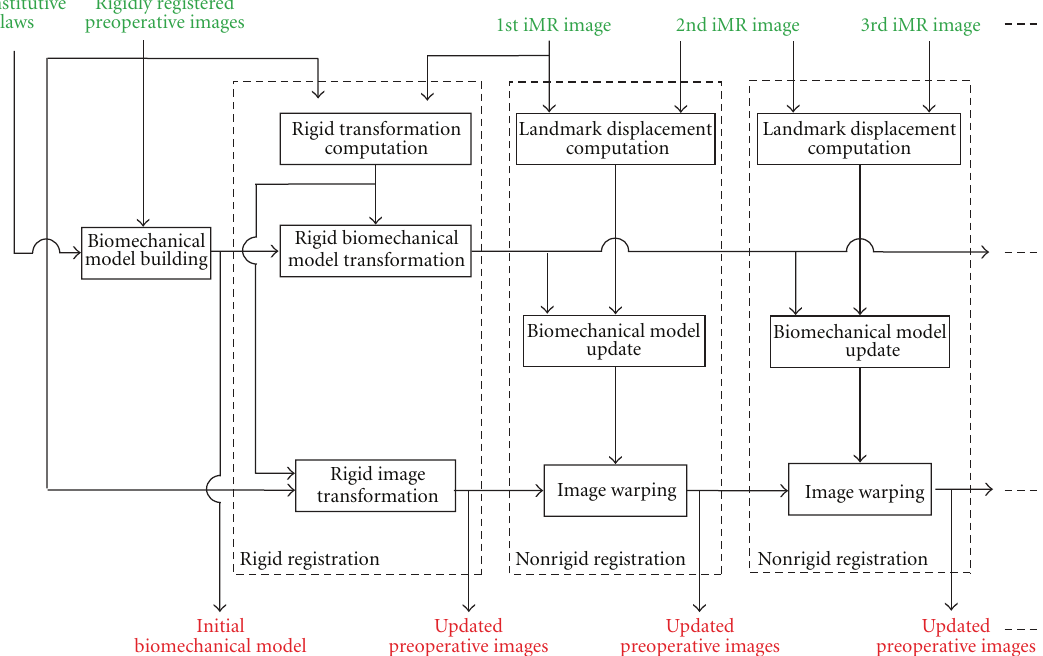
Figure 1: Block diagram of our serial preoperative image-update system dealing with successive brain deformation for a linear